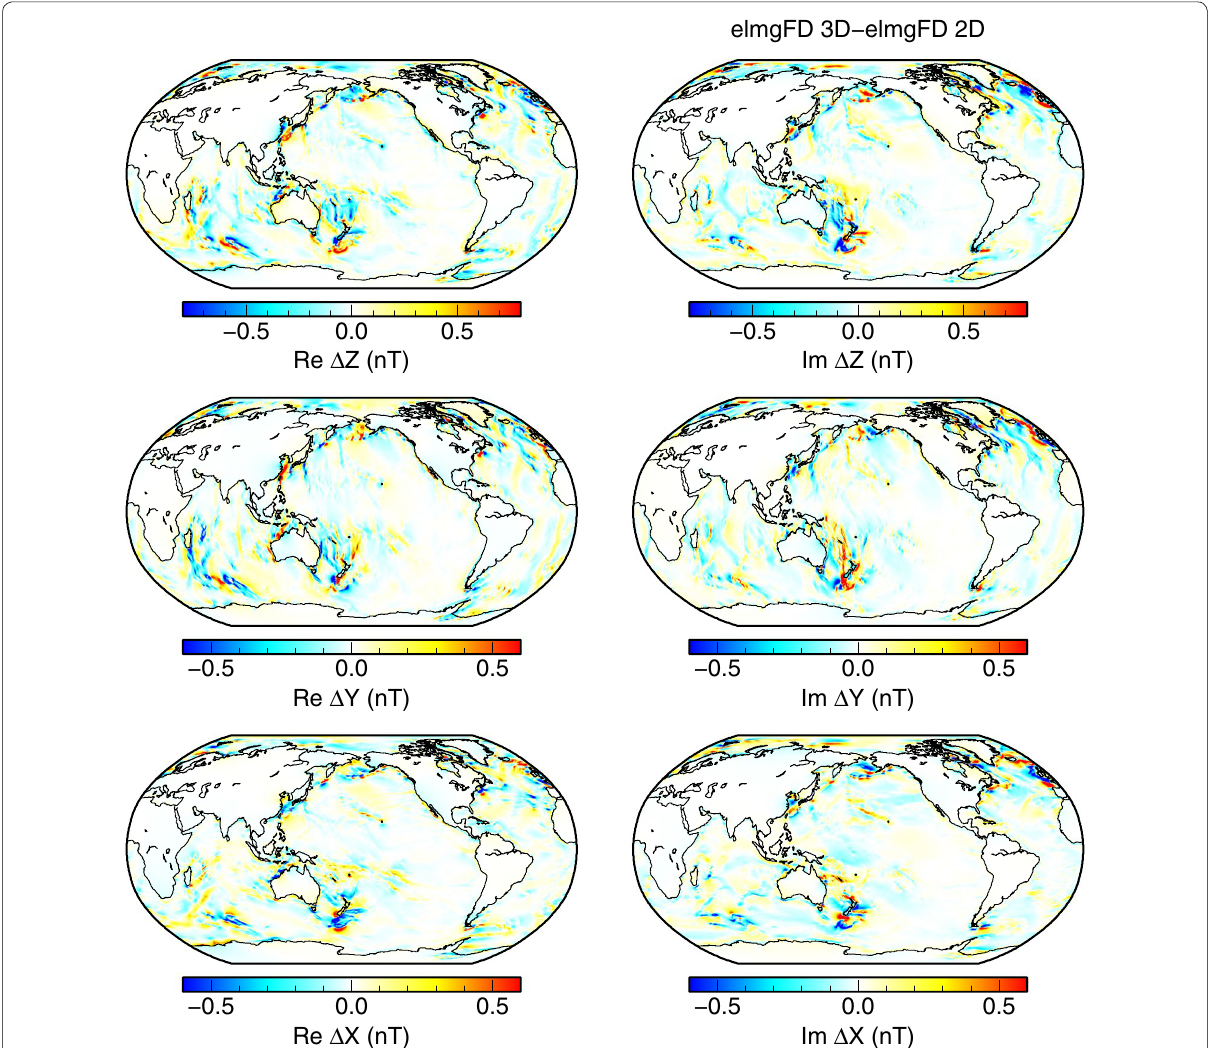
Fig. 6 Effect of dimensionality. Differences between the 3-D and 2-D solutions calculated at the Earth’s surface with the elmgFD code at j max = 480 . The 3-D solution discretizes the ocean with 40 equidistant